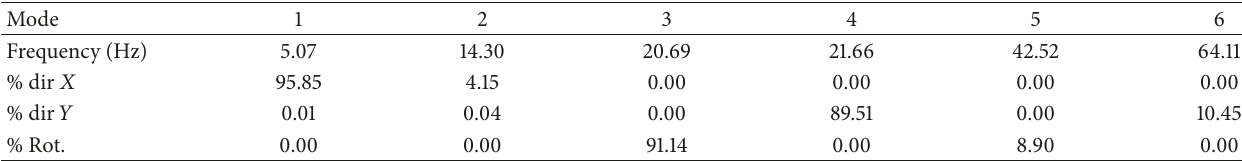
Table 10: Structure B FE model frequencies and excited